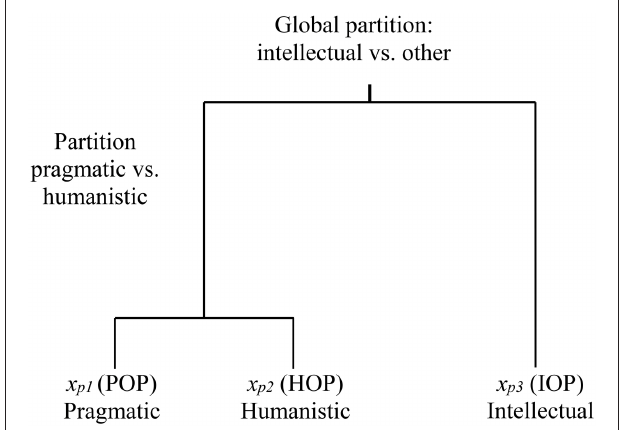
FIGURE 3 | Sequential partition of philosophical